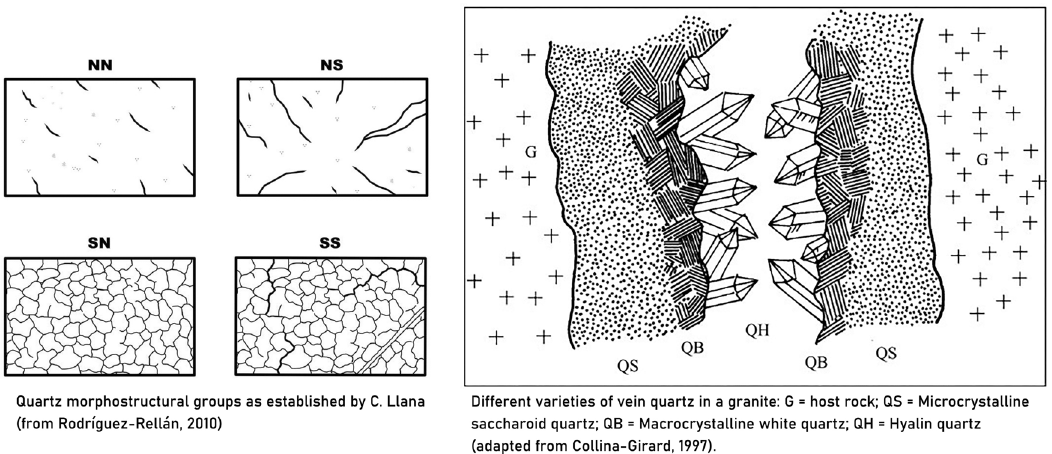
Figure 3: Quartz morphostructural